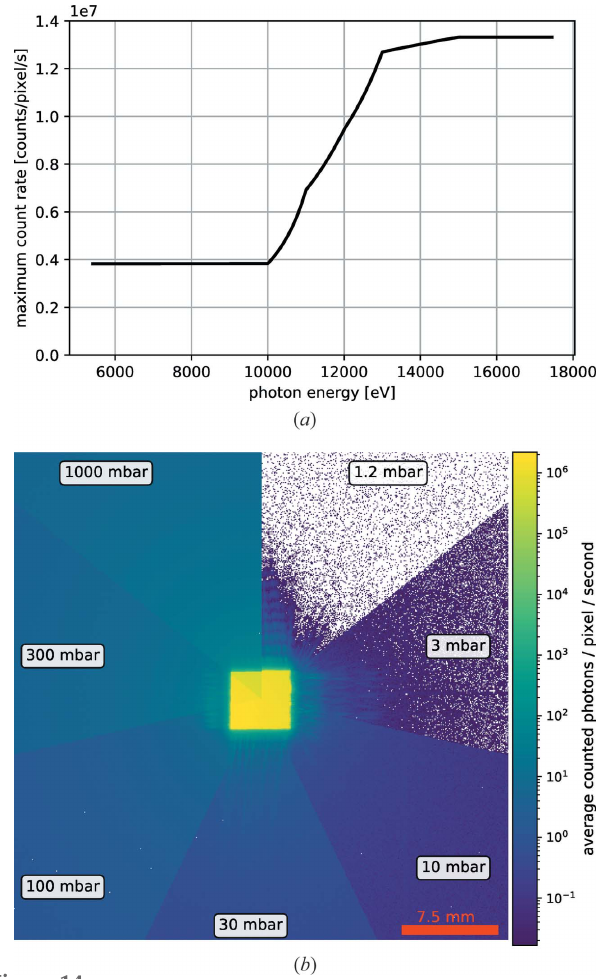
Figure 14 ( a ) Maximum count rate per pixel of the Eiger2 X 4M depending on the incident-beam photon energy. ( b ) Improvement of the (air-)scattering background with the reduction of pressure inside the flight tube, housing the Eiger2 X 4M detector. The presented data are frames averaged over 180 s. The images show the transmitted beam on the detector at 3.51 m distance from the focus, with a photon energy of 12.4 keV and a secondary source aperture of 8 m m (horizontal) (cid:5) 5 m m